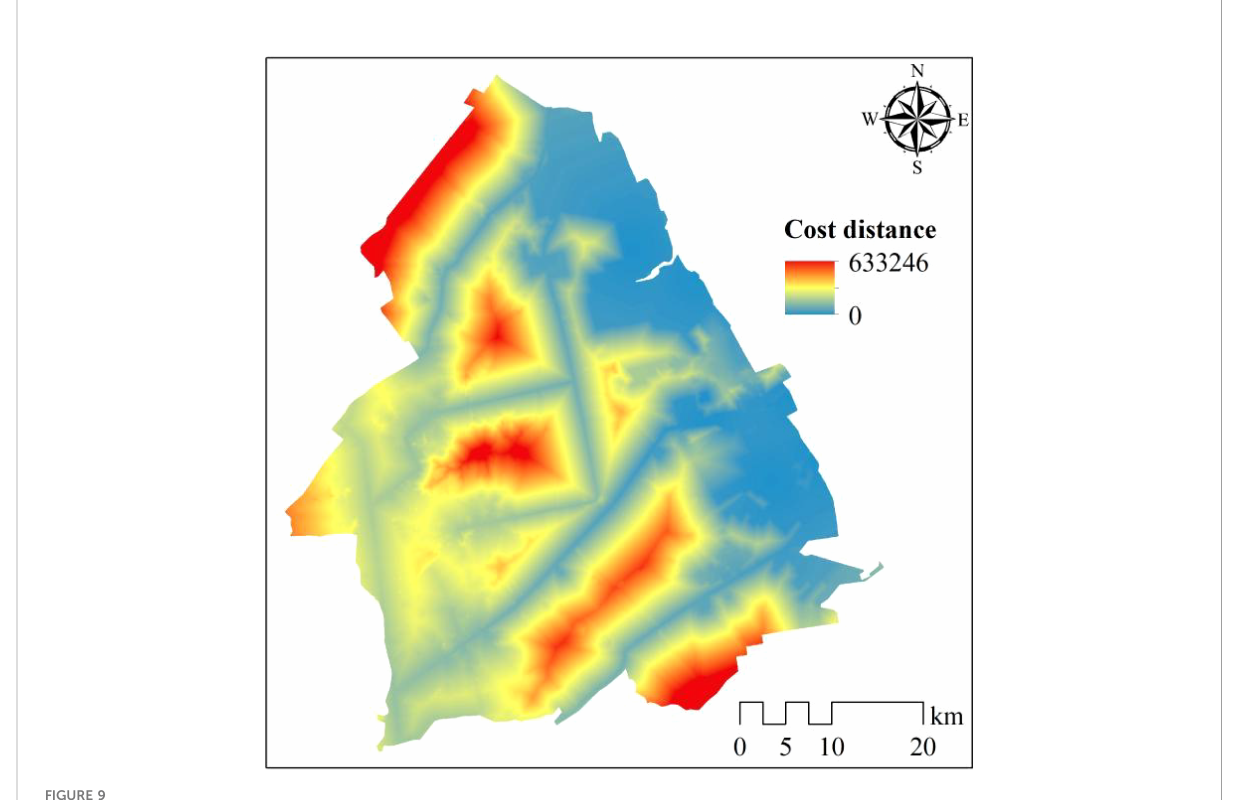
FIGURE 9 Landscape cumulative cost distance